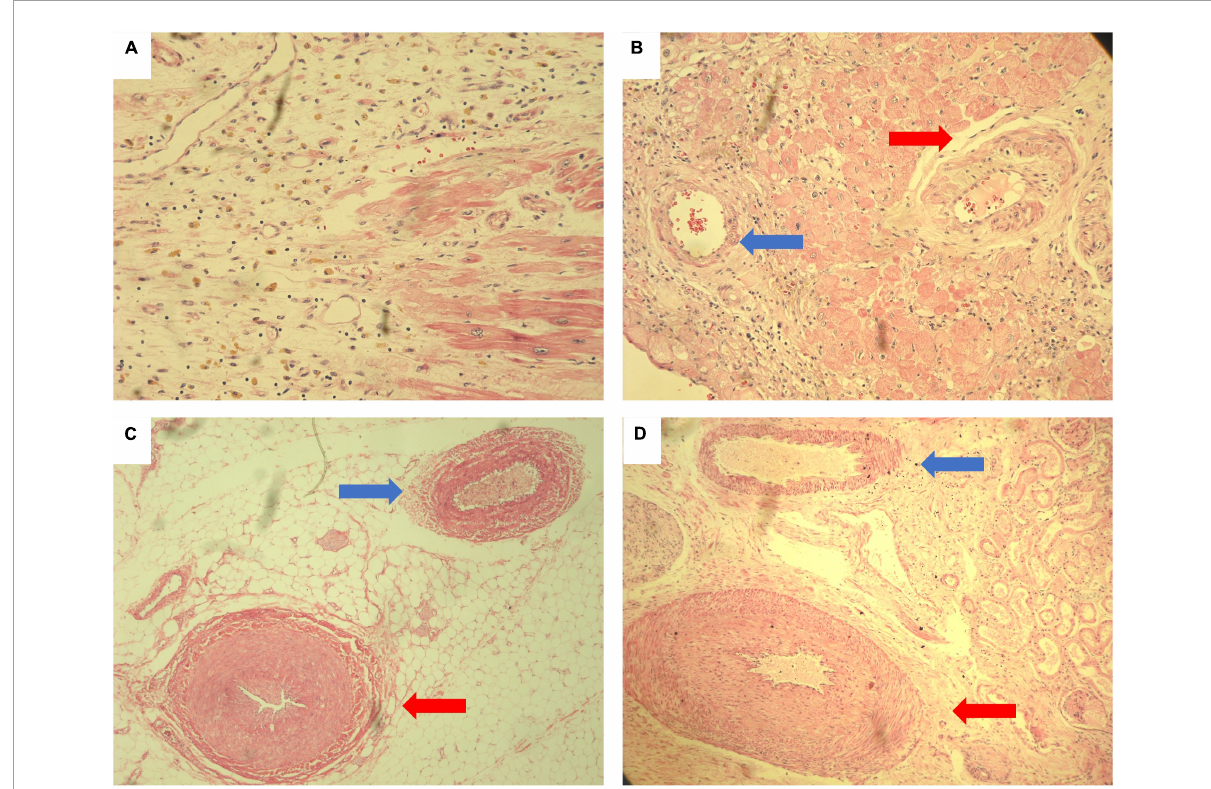
FIGURE4 Histological autopsy samples stained with hematoxylin and eosin. Myocardial necrosis with reparative granulation tissue formed by fibroblasts with initial deposits of collagen fibers. Numerous pigmented macrophages (whose cytoplasm is reddish) and abundant new vessels. Findings compatible with acute myocardial infarction of 10 to 14 days of evolution. (A) Intramyocardial coronary artery with marked thickening of the wall and reduced lumen (red arrow). There are spindle cells with the appearance of reparative fibroblasts that cause a disorganized appearance for comparison. On the left (blue arrow), an artery with normal characteristics is observed. (B) Medium caliber mesenteric artery (red arrow) with marked thickening of the wall that reduces the lumen to a cleft. In comparison, a mesenteric artery with normal characteristics is observed (blue arrow). (C) Medium caliber renal artery with marked thickening of the wall due to intimal hyperplasia that significantly reduces the lumen of the vessel (red arrow). Above (blue arrow) a renal artery with normal characteristics (D)